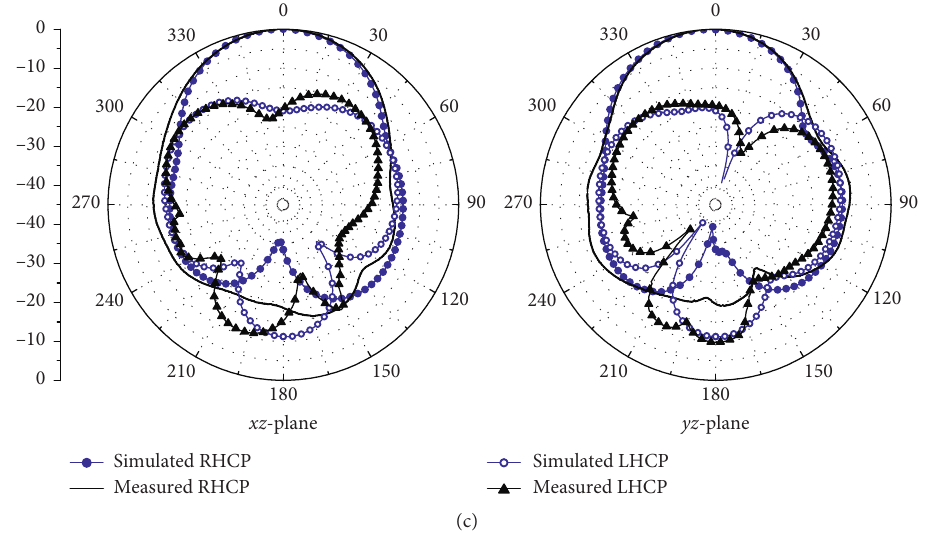
Figure 18: Measured and simulated radiation patterns of the proposed antenna at (a) 1.65, (b) 1.9, and (c) 2.15GHz. Table 2: Comparisons of the proposed and other CP antennas. Ref. year